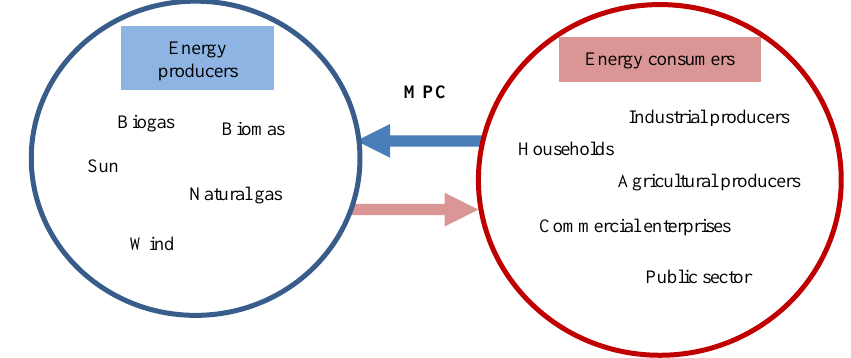
Fig. 3. Parties involved in receipt and payment of